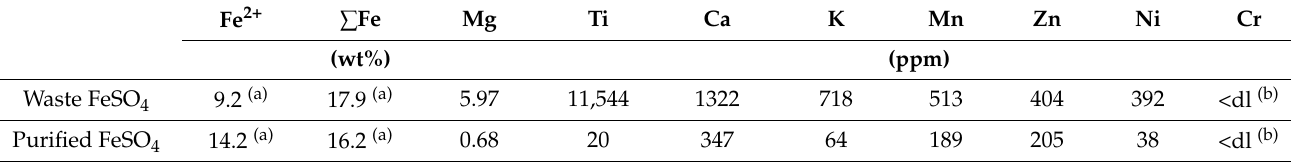
Table 1. Content of elements in waste and purified FeSO 4